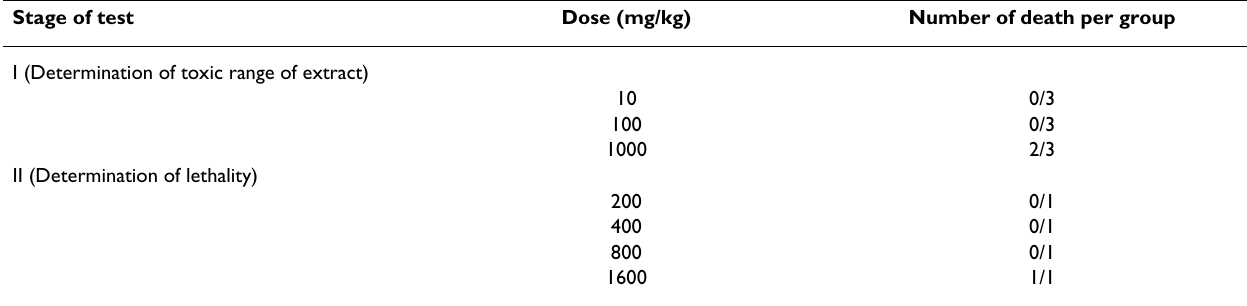
Table 2: Result of acute toxicity and lethality (LD 50 ) test Stage of